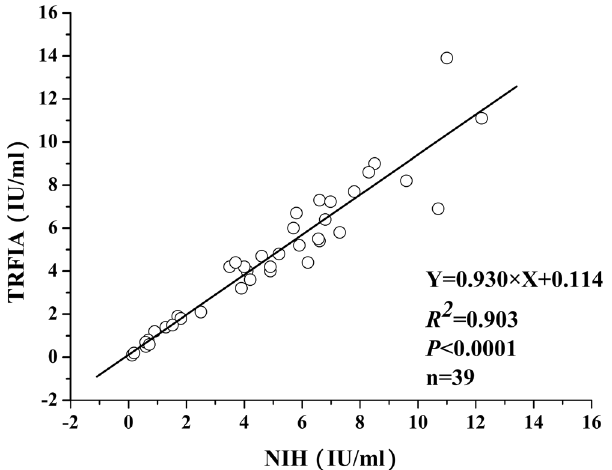
Figure 6. Graphical comparisons of the present TRFIA and NIH test results for evaluation of the potency of rabies vaccine